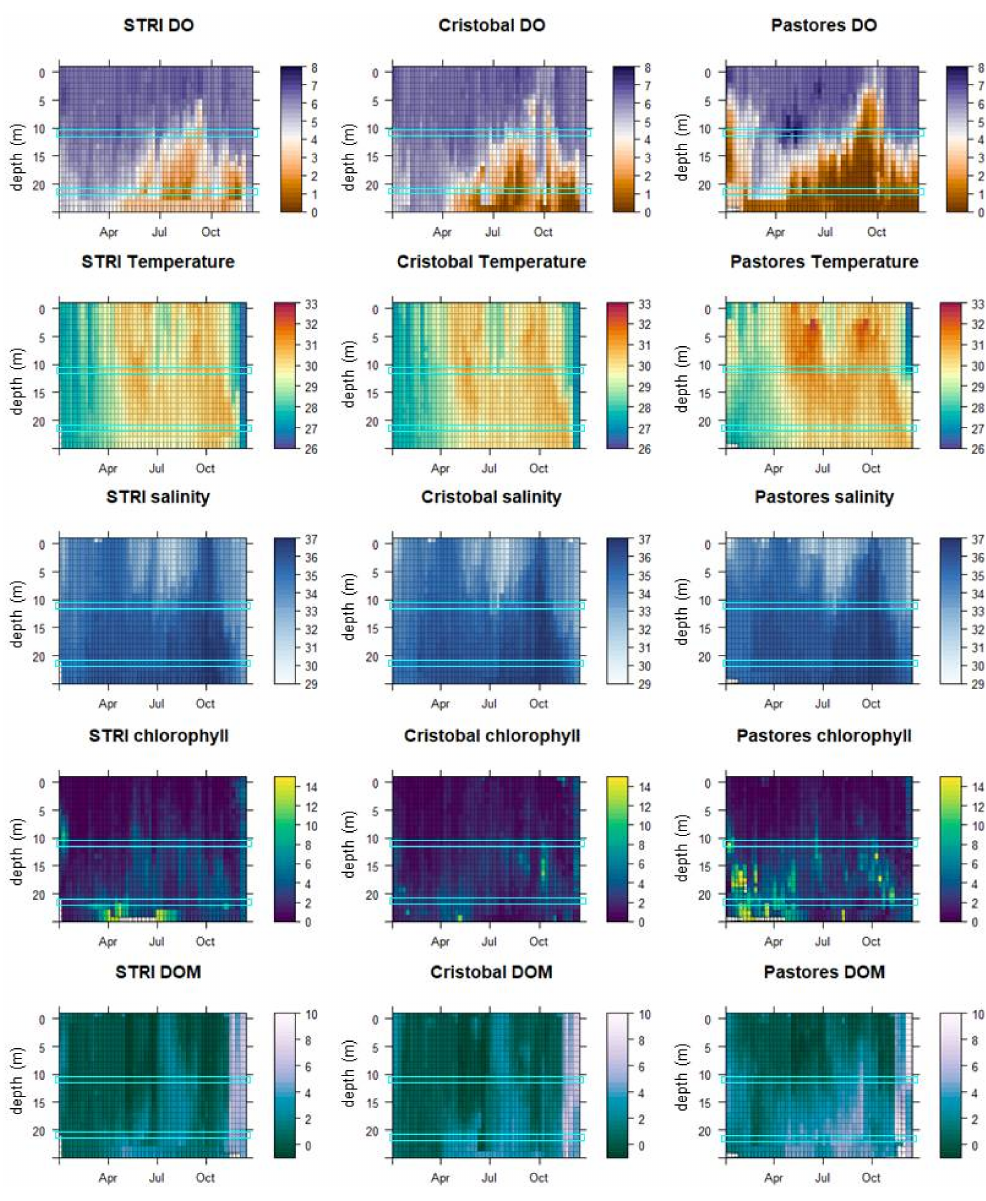
Figure 2. Environmental conditions at each site over the period of the project, as measured weekly by the YSI sonde: Dissolved oxygen (DO, mg L − 1 ); temperature ( ◦ C), salinity, chlorophyll ( µ g L − 1 ), and dissolved organic matter (DOM, QSU). Value ranges for visualization were chosen to maximize visible contrast of conditions present at 11 and 21 m (highlighted with cyan rectangles), resulting in the truncation of some outlier values in salinity, chlorophyll, and DOM, mostly at the surface and